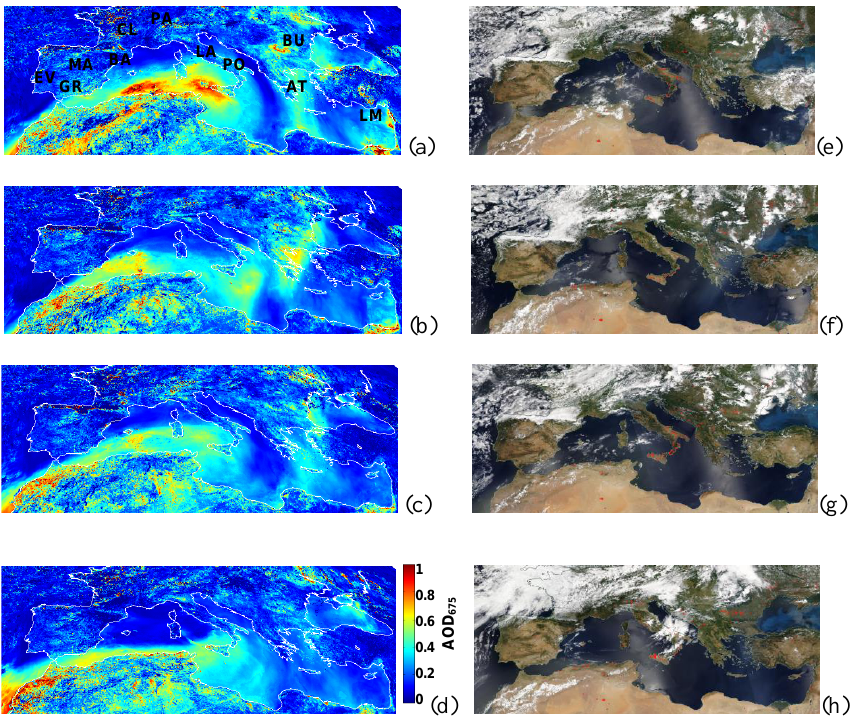
Figure 4. MSG/SEVIRI AERUS-GEO daily AOD at 675nm on (a) J09, (b) J10, (c) J11 and (d) J12. Aqua/ and Terra/MODIS fire overlays on (e) J09, (f) J10, (g) J11 and (h) J12 from https://earthdata.nasa.gov/labs/worldview/. The legend of (d) applies for (a) , (b) and (c)